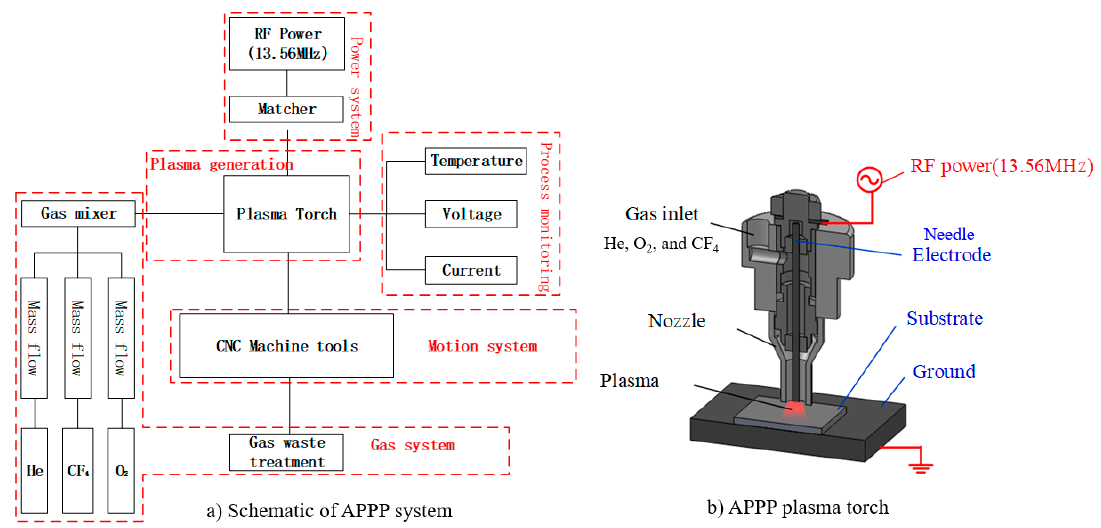
Figure 1. Schematic diagram of the atmospheric pressure plasma processing (APPP) system, reproduced with permission from [19].